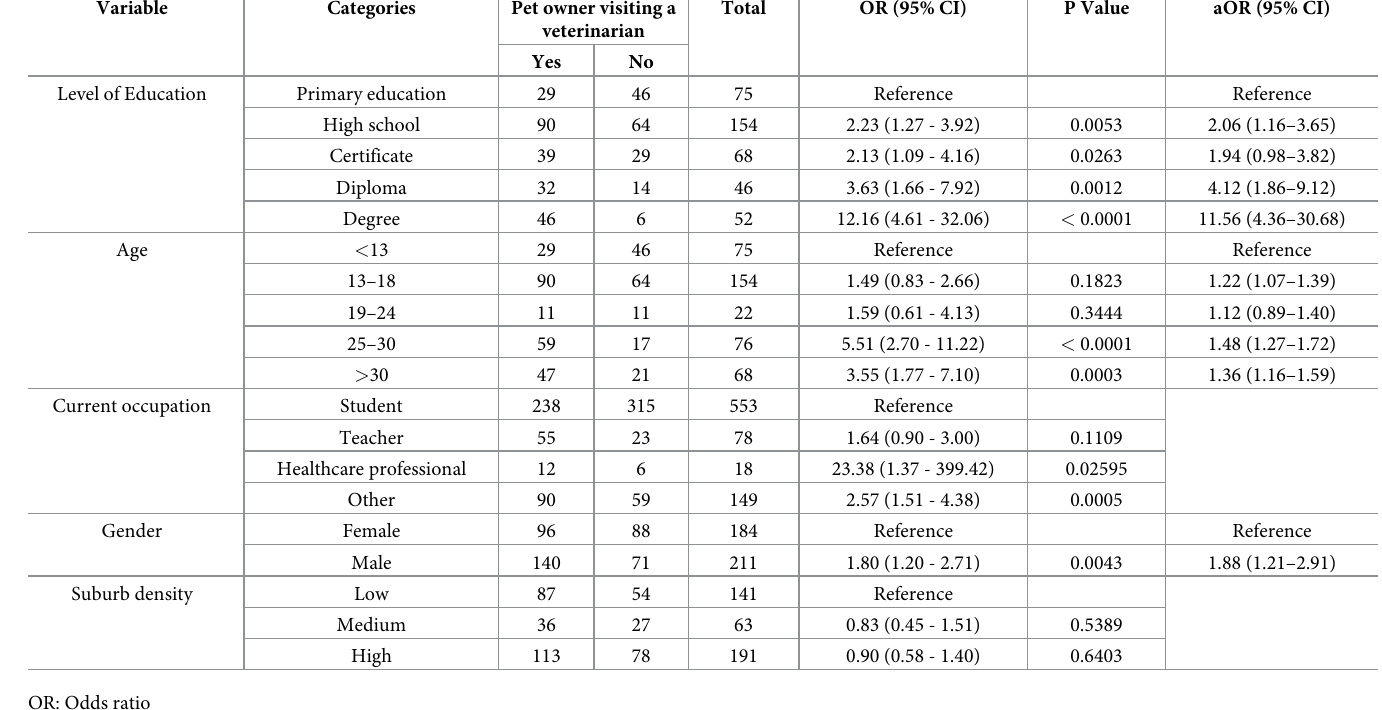
Table 6. Univariate and multivariable logistic regression analysis of the association between the socio-demographic variables and “pet owners seeking animal health services”.